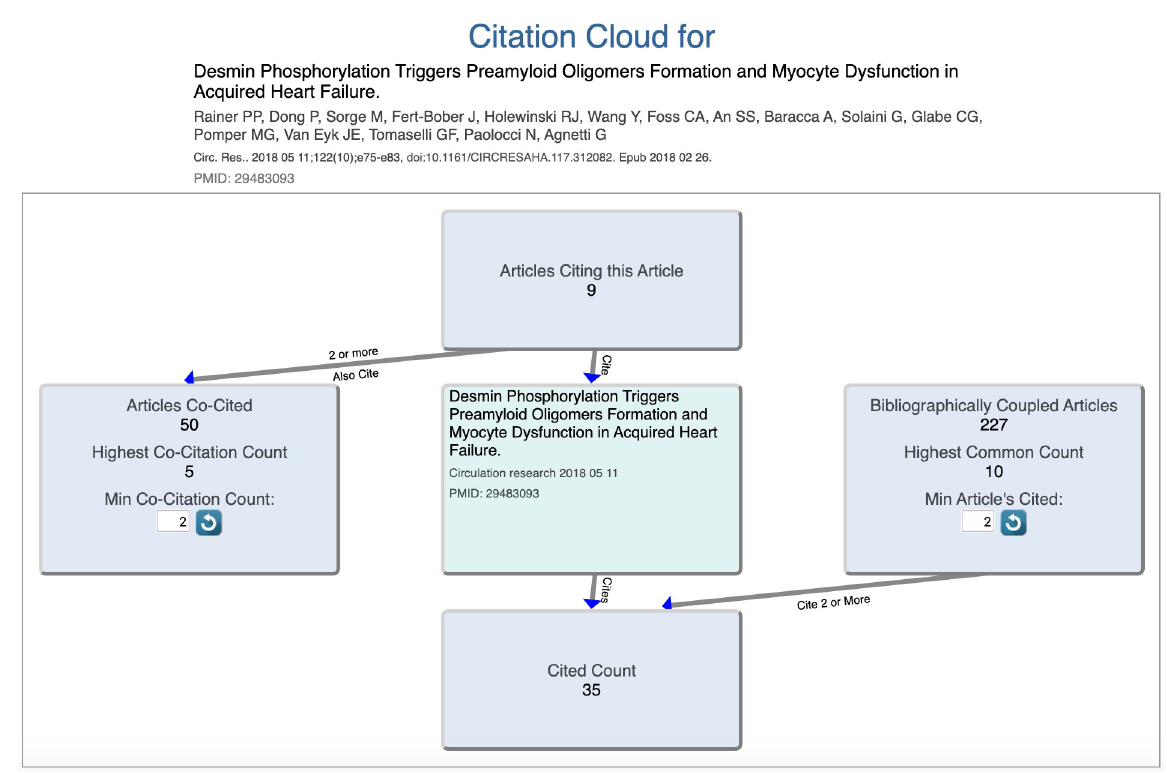
Fig 7. Screenshot of the citation cloud for the target article: Rainer et al., desmin phosphorylation triggers preamyloid oligomers formation and myocyte dysfunction in acquired heart failure. Circ Res. 2018 May 11;122(10):e75-e83.